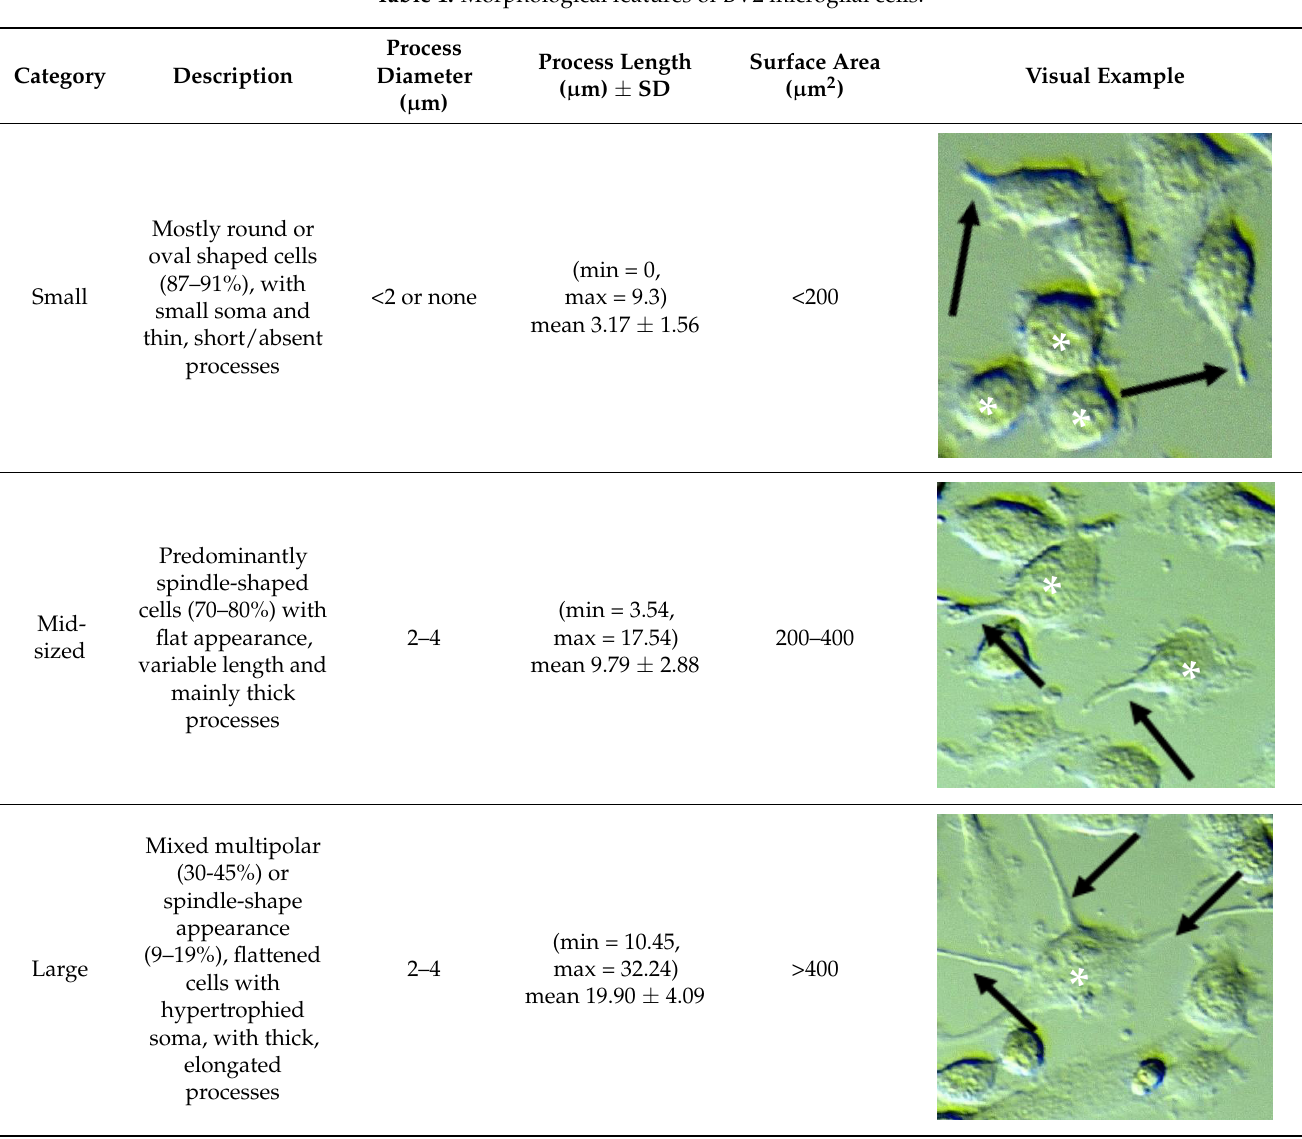
Table 1. Morphological features of BV2 microglial cells.